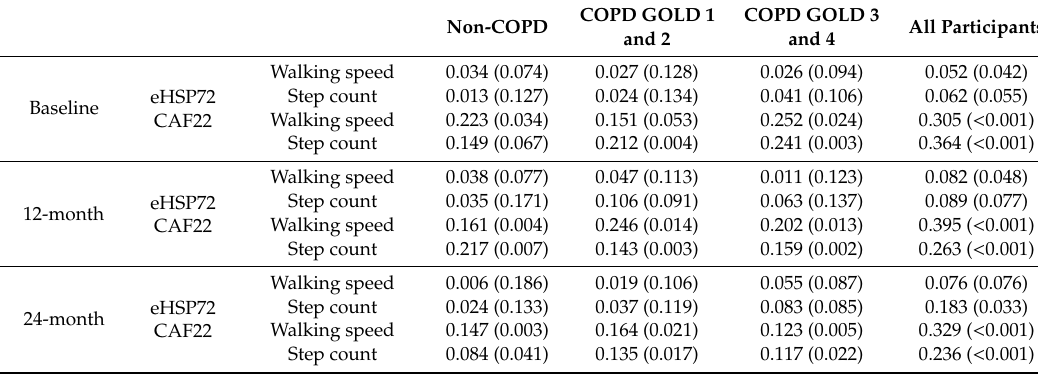
Table 3. Correlations coe ffi cients of plasma biomarkers with walking speed and daily steps count at various time points ( N = 64–68 / group / time point). The numbers in parenthesis indicate p -values.